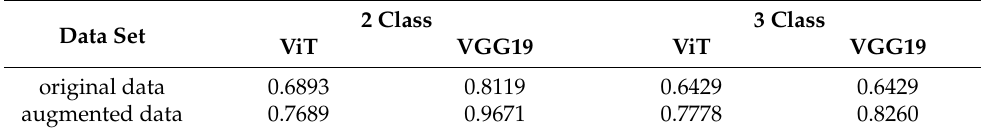
Table 8. Three-class classification performance of ViT and